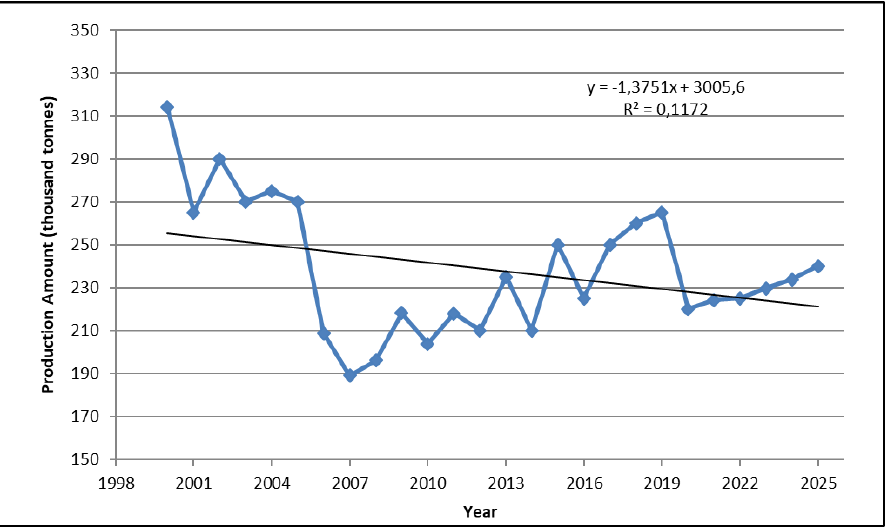
Figure 5: Oats production amount in Turkey